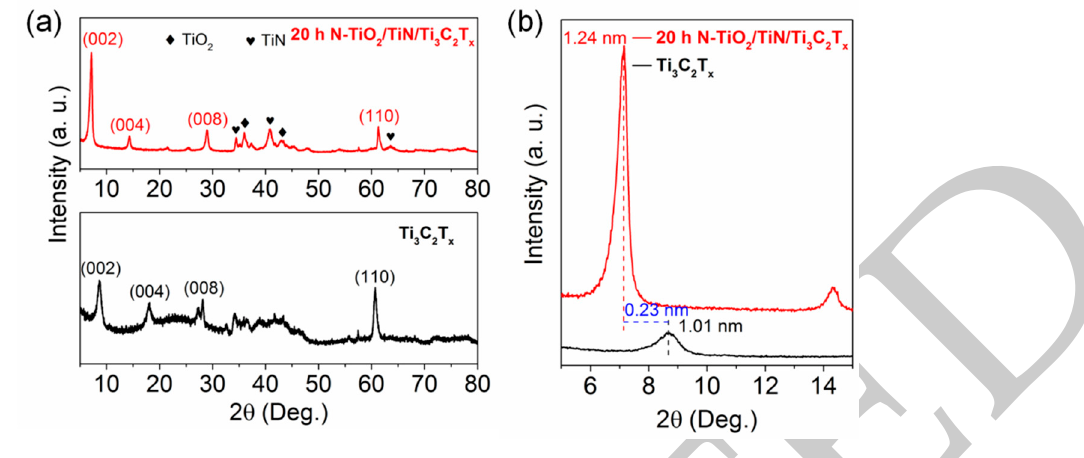
Figure 2. ( a ) XRD patterns of Ti 3 C 2 T x and 20 h N-TiO 2 / TiN / Ti 3 C 2 T x , ( b ) XRD patterns of Ti 3 C 2 T x and 20 h N-TiO 2 / TiN / Ti 3 C 2 T x over a small range of 2 θ from 5–15 ◦ .